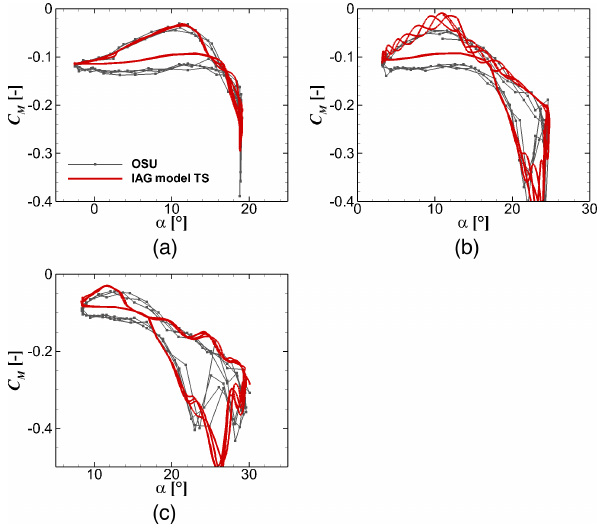
Figure 14. Pitching moment reconstruction by the IAG model in comparison with the measurement data (Ramsay et al., 1996) for (cid:49)t = T/ 1440 using the actual angle of attack in the experimental campaign at various α values. From (a) to (c) : α = 8, α = 14 and